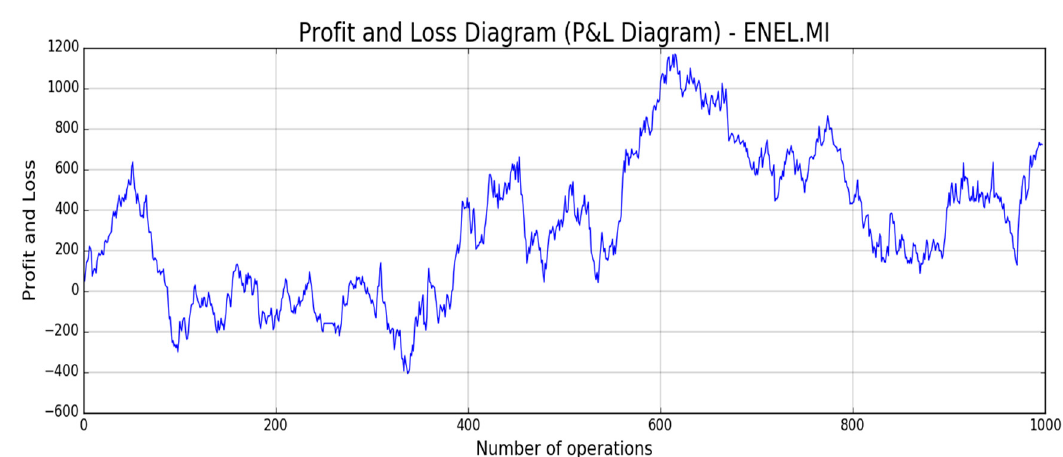
Figure 21. ISP.MI Profit and Loss Diagram.